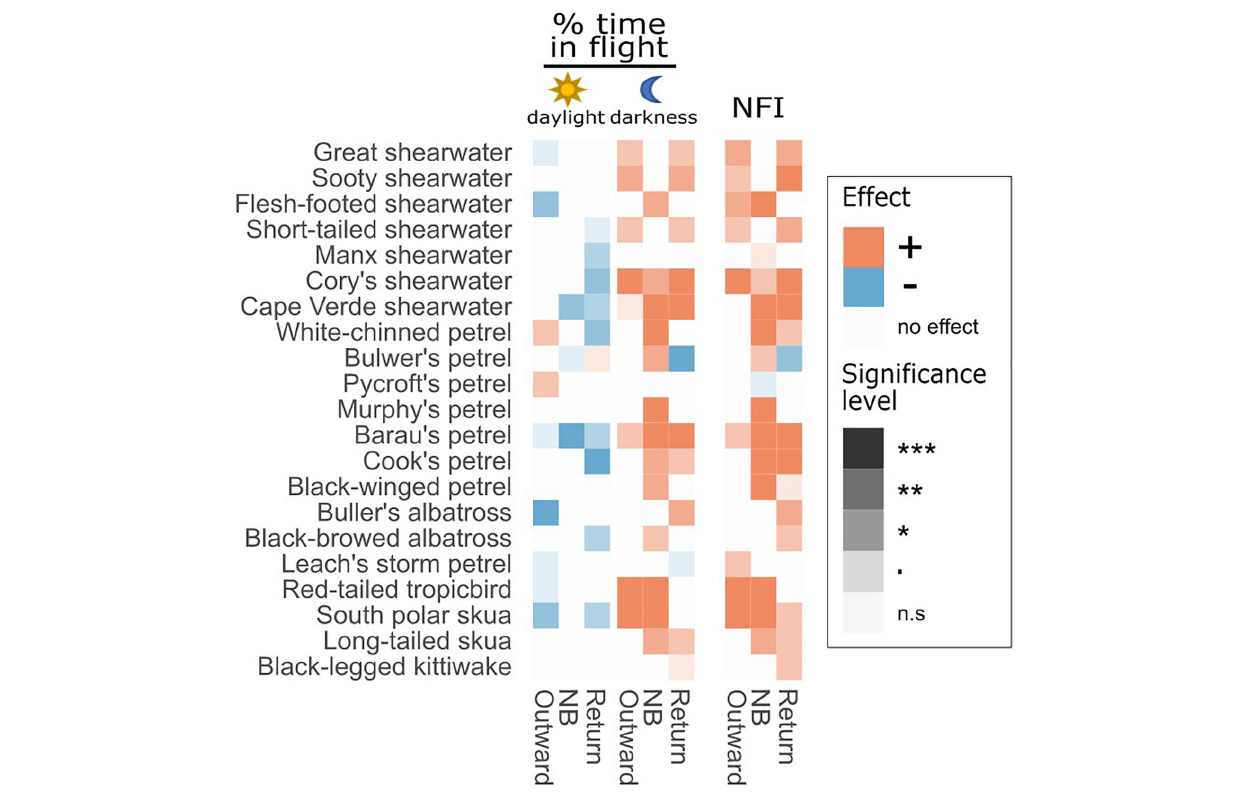
FIGURE 7 | Behavioural changes during full moon compared with new moon. Colours and shades represent the results of LMMs testing the effect of the moon phase on two response variables: % of time in flight and the night flight index (NFI). Orange squares indicate that the value was significantly higher during the full moon than during the new moon period, blue squares represents the opposite effect and white squares that there was no significant difference. Effects are tested separately among stages of the non-breeding season (outward migration, NB: non-breeding period, return migration) and daylight vs. darkness, as appropriate. Significance levels: “***” = p -value < 0.001, “**” = p -value < 0.01, “*” = p -value < 0.05, “.” = p -value < 0.1, “n.s” =